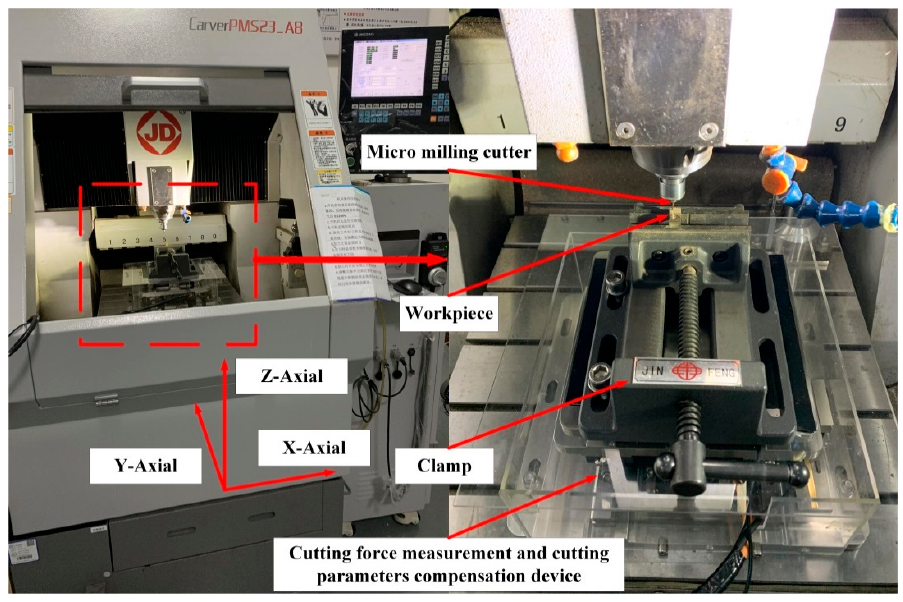
Figure 10. Experiment setup.